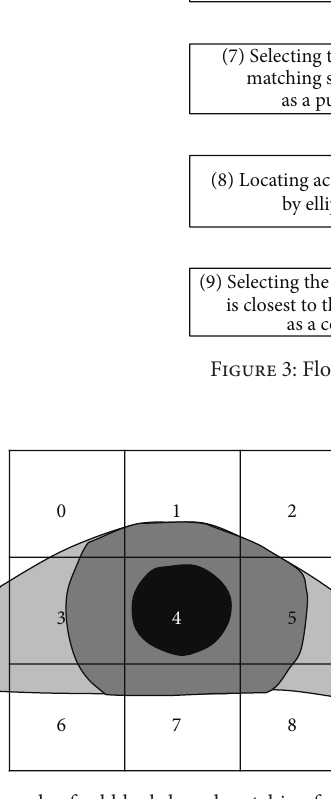
Figure 4: Example of subblock-based matching for pupil detection.